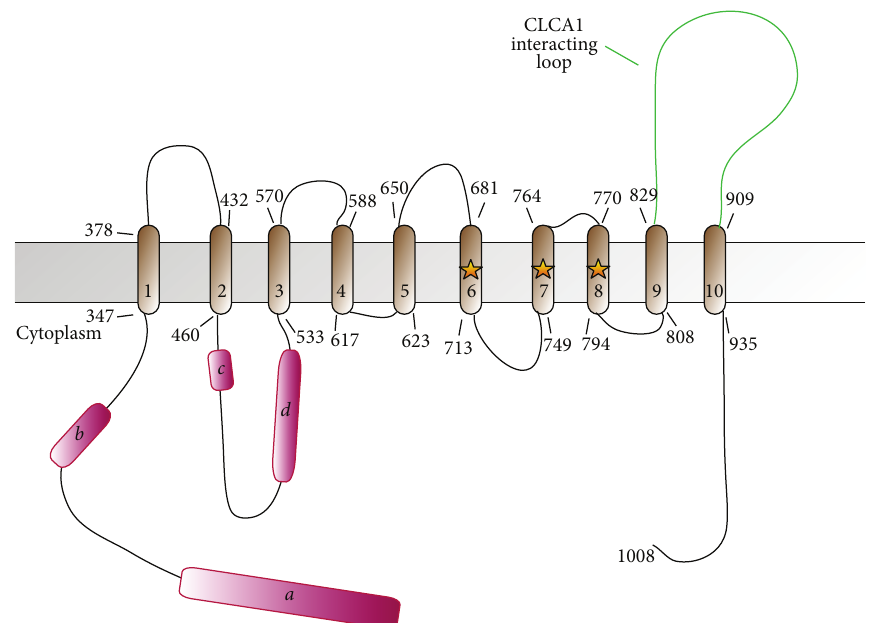
Figure 3: Domain architecture schematic for human TMEM16A. Topology shown is predicted from structure-based alignment to the crystal structure of the fungal Nectria haematococca TMEM16 [31]. Alternative splicing segments 𝑎 , 𝑏 , 𝑐 , and 𝑑 are shown in magenta. The location of residues of a crystallographically determined Ca 2+ binding site is highlighted with stars. The extracellular loop mediating interaction with CLCA1 is highlighted in